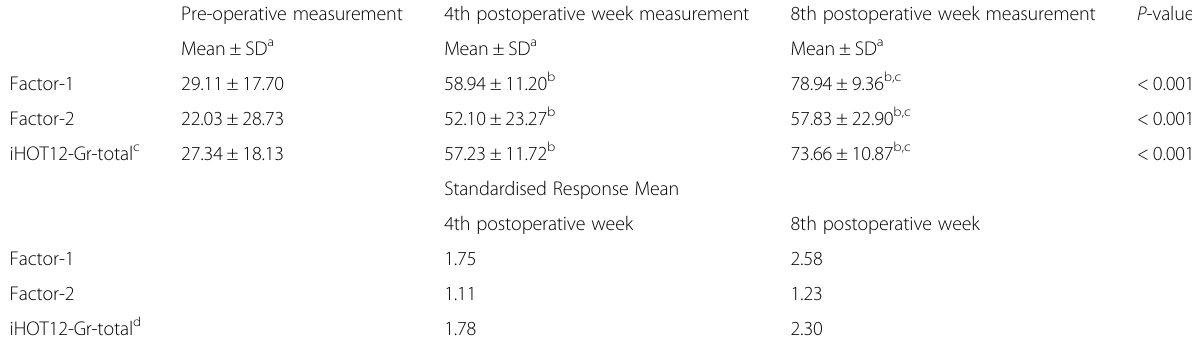
Table 7 Responsiveness of the international Hip Outcome Tool (12 items) - Greek version ( n = 25) Pre-operative